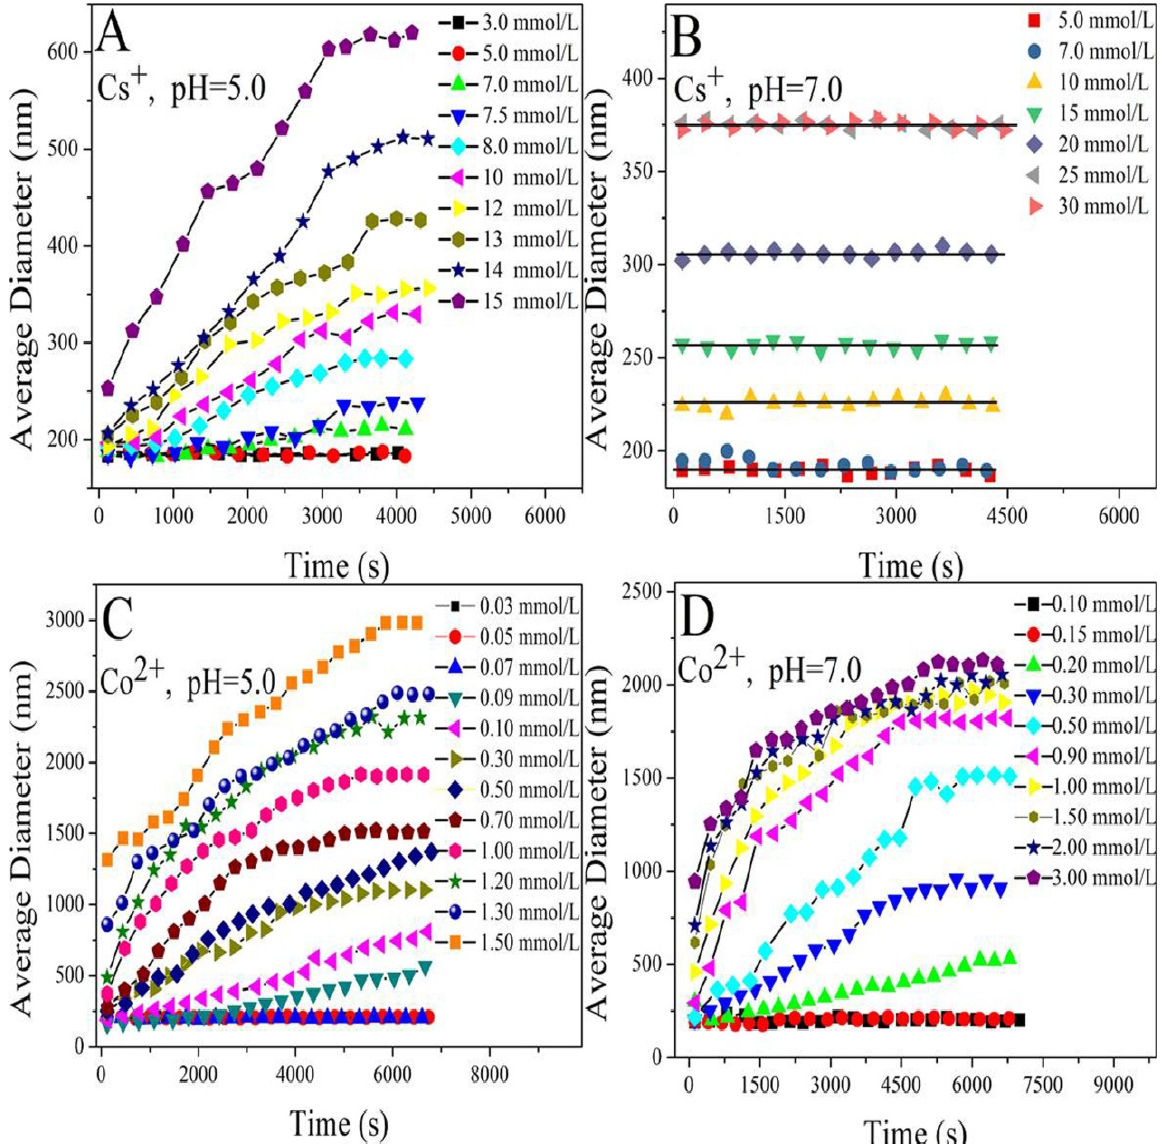
Figure 1. The hydrodynamic diameter changes in HA aggregates (50 mg/L) as a function of metal ion concentration under different pH conditions. (( A ): Cs + ion with different concentrations at pH 5.0; ( B ): Cs + ion with different concentrations at pH 7.0; ( C ): Co 2+ ion with different concentrations at pH 5.0; ( D ): Co 2+ ion with different concentrations at pH 7.0).